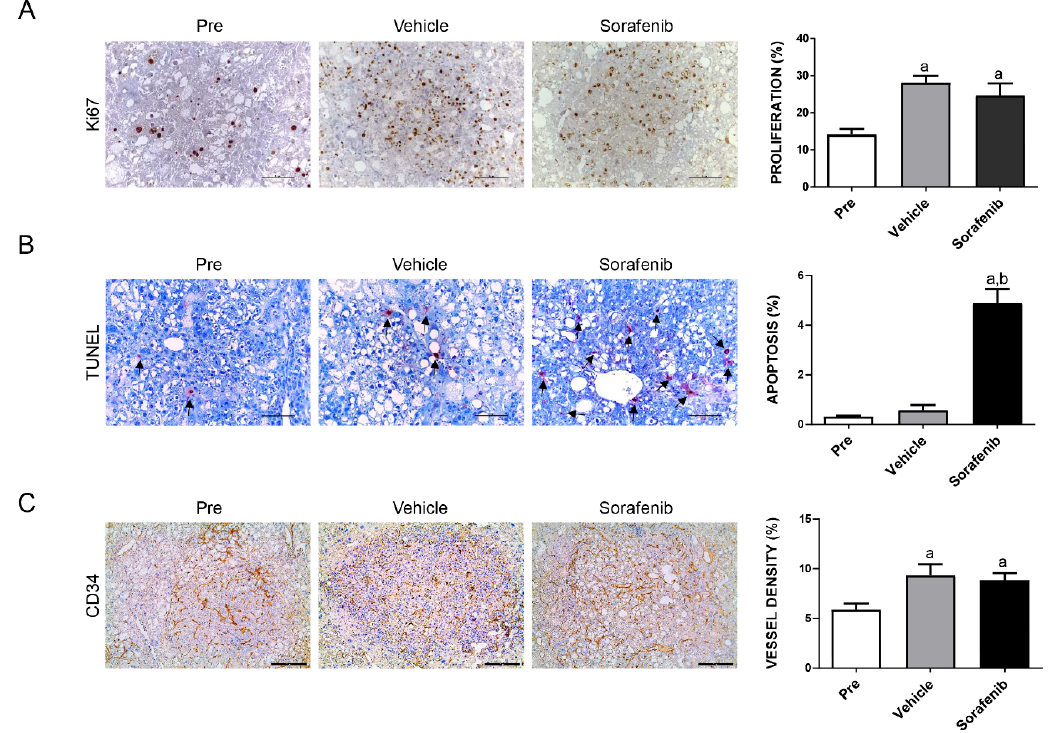
Figure 2. E ff ects of treatment with sorafenib on the AKT / c-MET mouse lesions, as determined by immunohistochemistry. Ki-67 ( A ) and TUNEL ( B ) staining in livers from AKT / c-MET mice subjected to the various treatments were quantified and represent the percentage of positive cells for proliferation and apoptosis, respectively. At least 3000 tumor cells per sample were evaluated. ( C ) CD34 staining in livers from AKT / c-MET mice subjected to the various treatments. The “vessel density” represents the percentage of CD34 staining area in each field from the sections as assessed by the ImageJ software. Tukey–Kramer test: at least p < 0.001. a, vs. Pre-treatment; b, vs. Vehicle. Abbreviations: Pre,